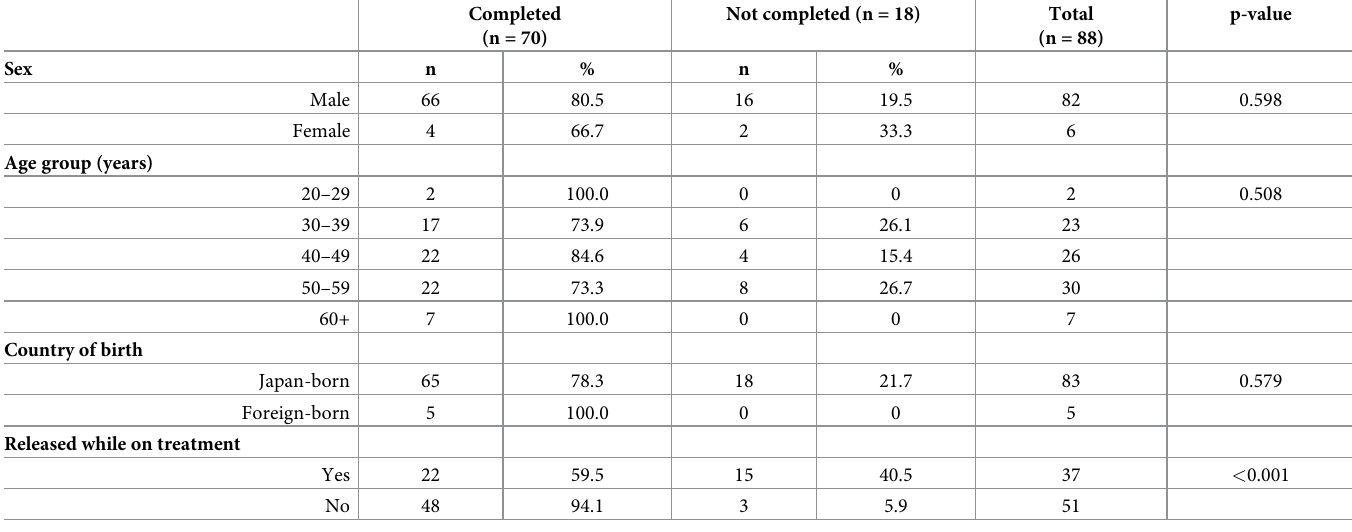
Table 4. Treatment outcome of LTBI by selected characteristics, 2015–2016 (n = 88).